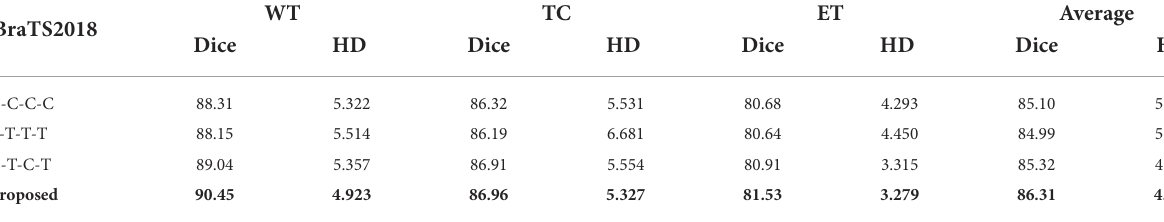
TABLE 4 Ablation experiment results on